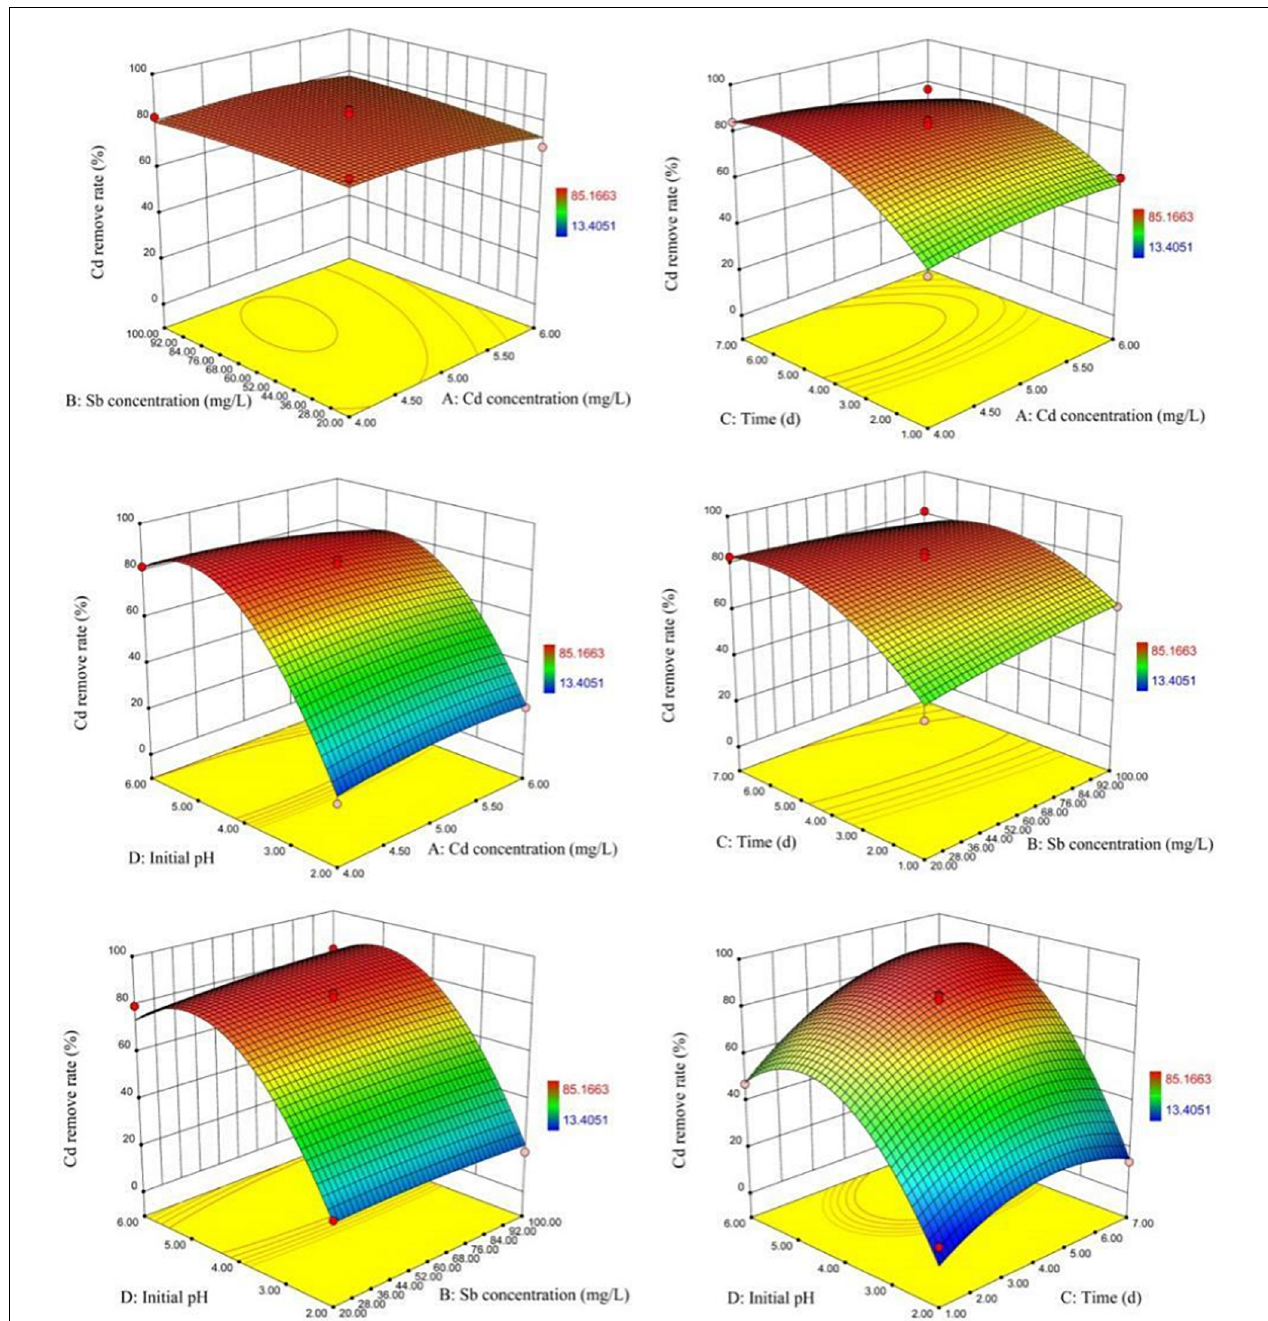
FIGURE 6 | Response surface curves for Cd(II) removal showing the binary